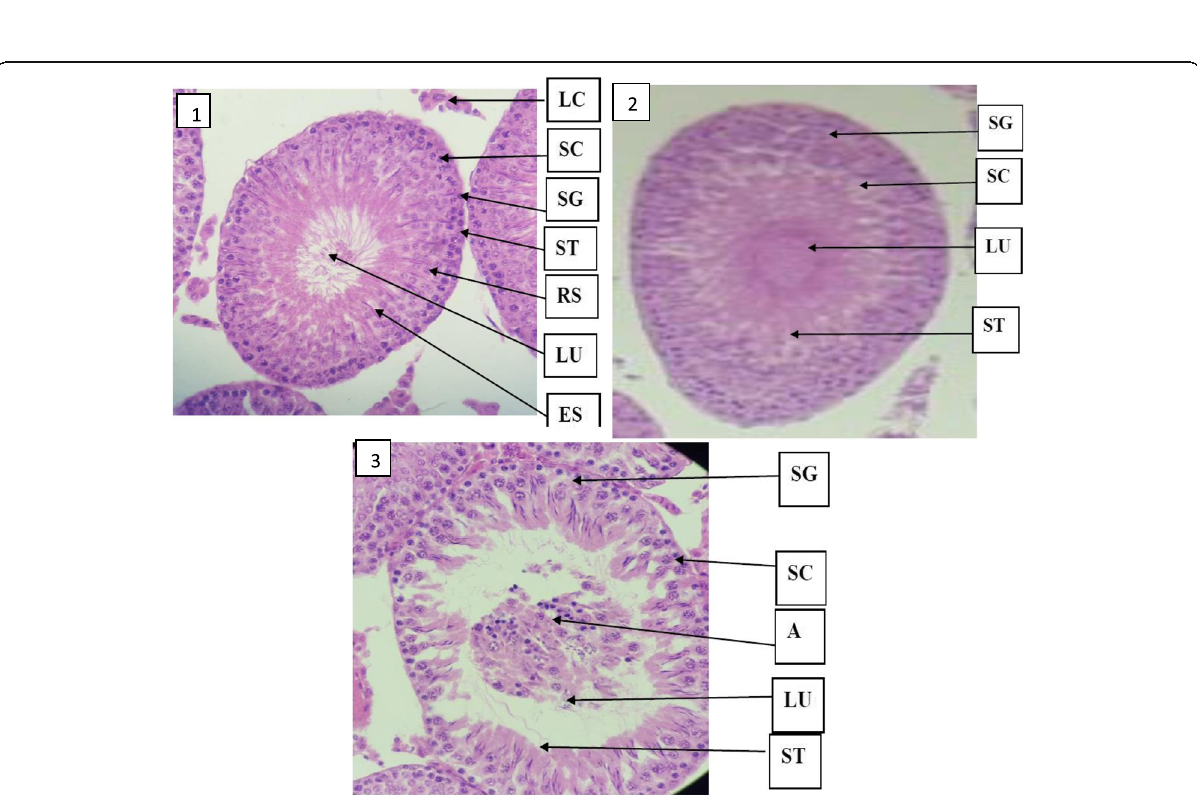
Fig. 6 Photomicrograph of histological sections of the testes of the experimental rats at week 4. H & E ×400. Plate 1; Control subgroup (1a). Sectioned area showing Interstitial cells of Leydig in the interstitial space (LC); Seminiferous tubule epithelium containing cells of the spermatogenic series including spermatogonia (SZ); spermatocyte (SC); Round spermatids (RS); elongated spermatids (ES) and sertoli cells and the lumen containing spermatozoa (LU). Plate 2: Treated subgroup (2a) with 250mg/kg body weight of aqueous root extract of Chrysophyllum albidum . Sectioned area shows spermatogenic cells in normal sequential maturation. Plate 3: Treated subgroup (3a) with 500mg/kg body weight of aqueous root extract of Chrysophyllum albidum . Sectioned area shows focal spermatogenic arrest at the stage of conversion from spermatocyte to spermatids (A). Spermatogenic cells in view include spermatogonia (SG); spermatocyte (SC). The lumen contains admixture of immature cells of the spermatogenic series